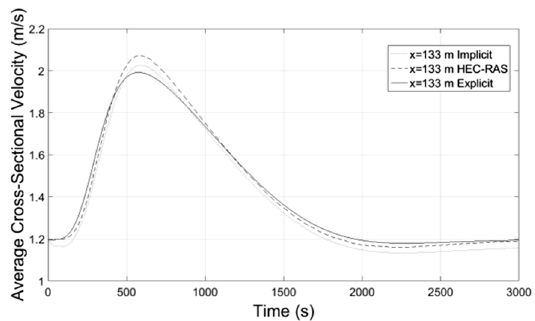
Figure 14. Average Velocity-Time at x = 133 m.